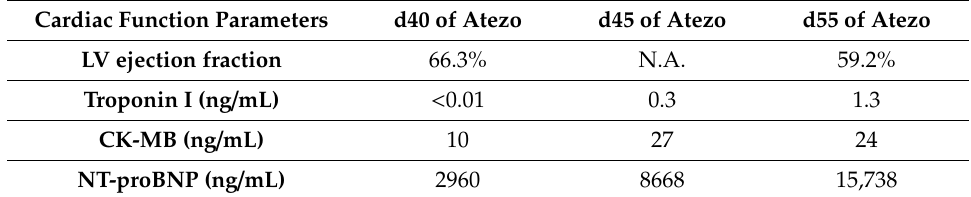
Table 1. Data from echocardiogram and serum cardiac enzyme levels. Cardiac Function Parameters d40 of